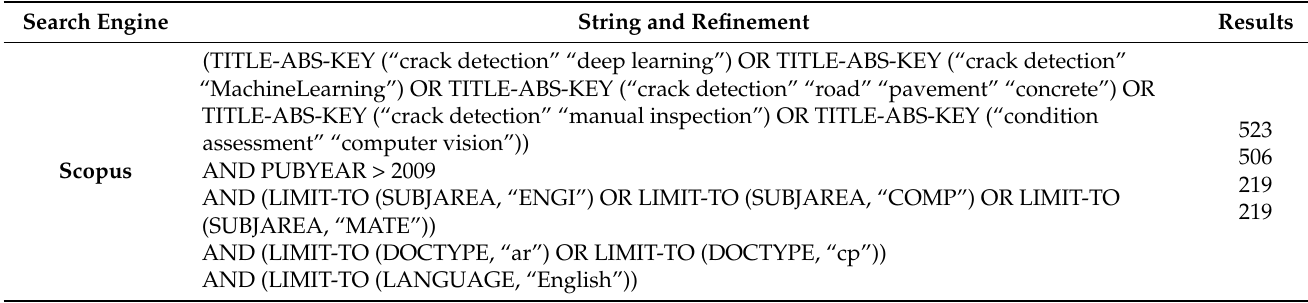
Table 1. The search string, refinements, and results of the Scopus and WoS repositories. Search